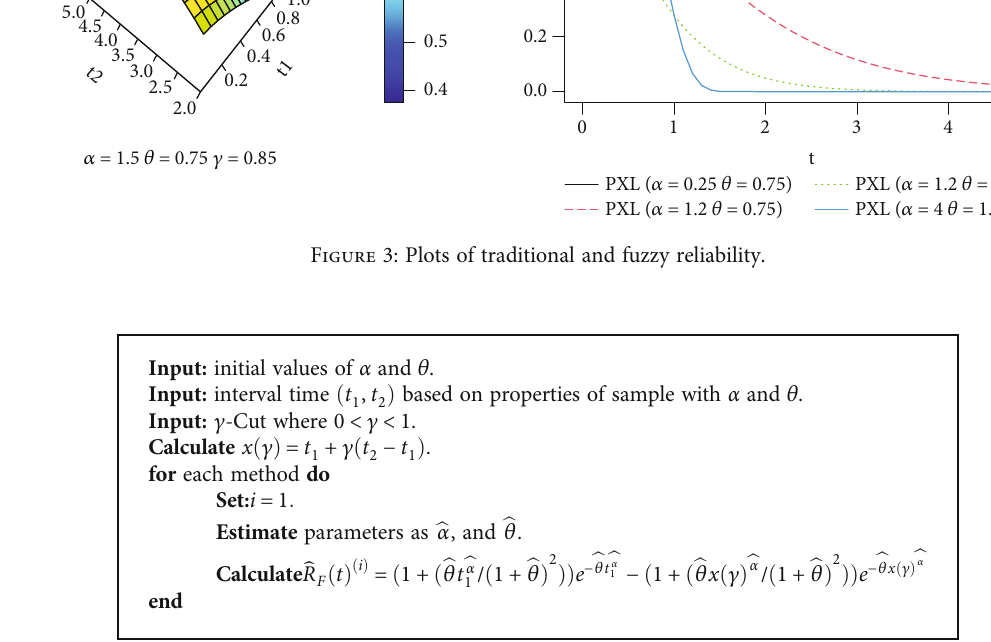
Algorithm 1: Fuzzy estimation